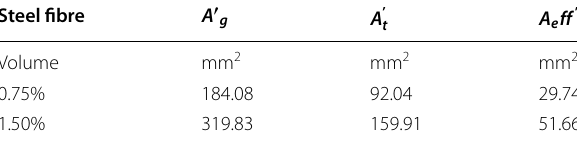
Table 7 Determined effective area of SF in resisting tension Steel fibre